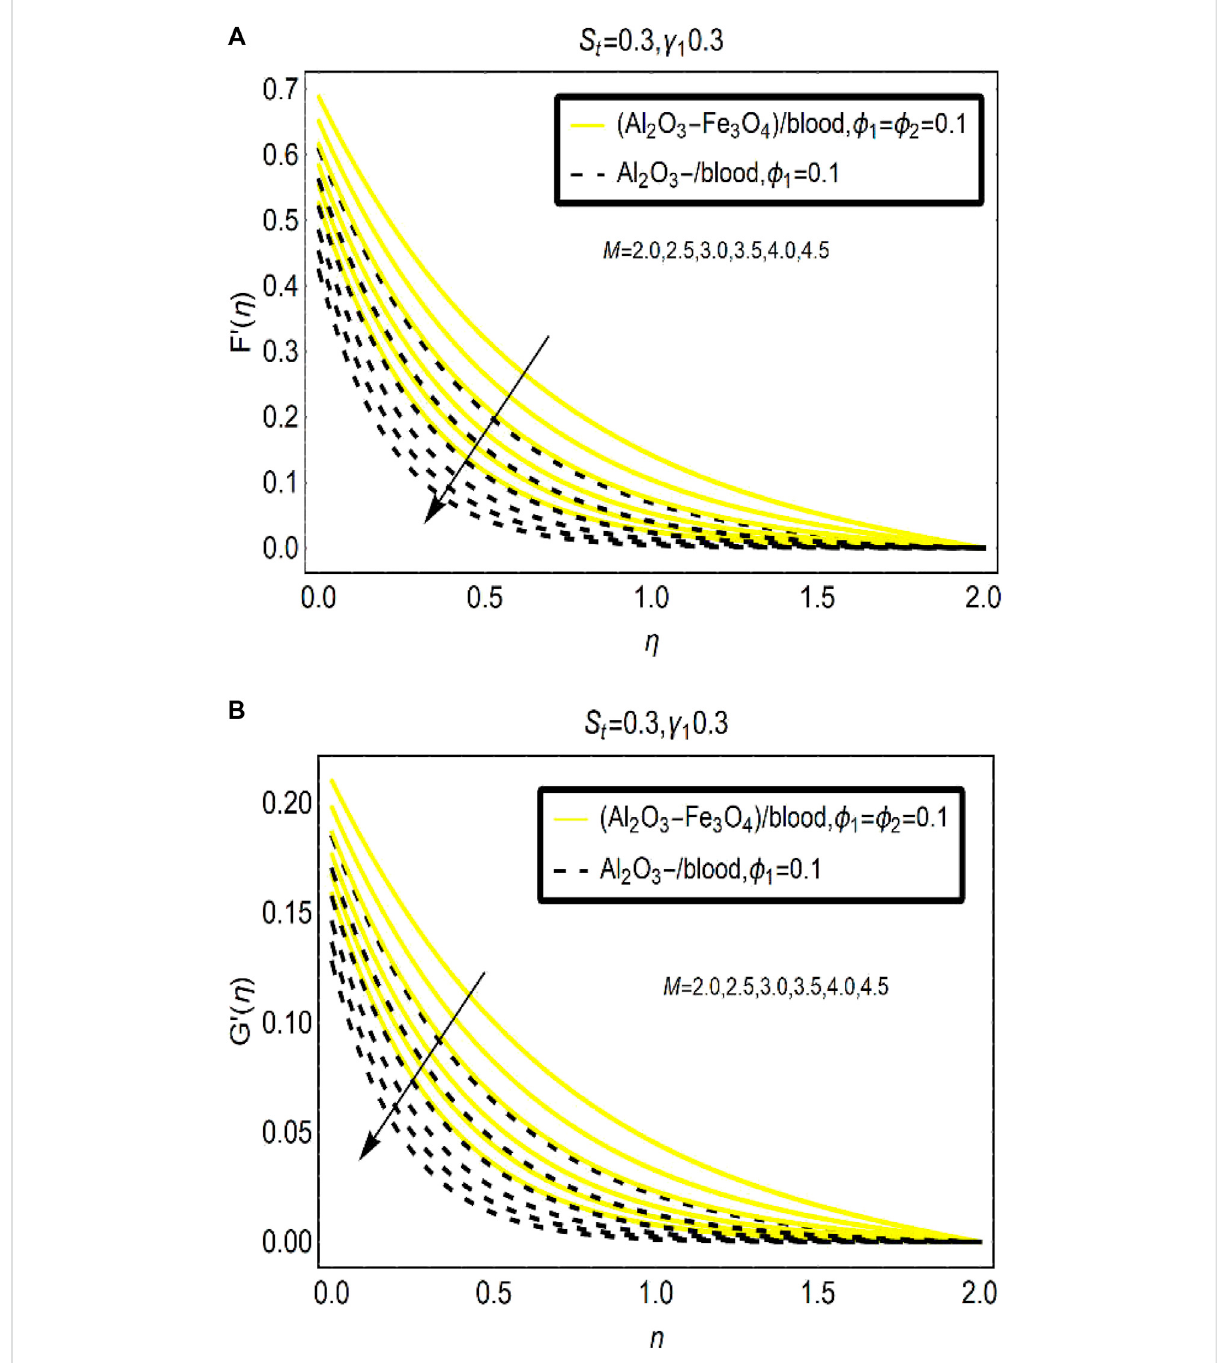
The velocity changes under varying M for (A) F ′ and (B) G ′